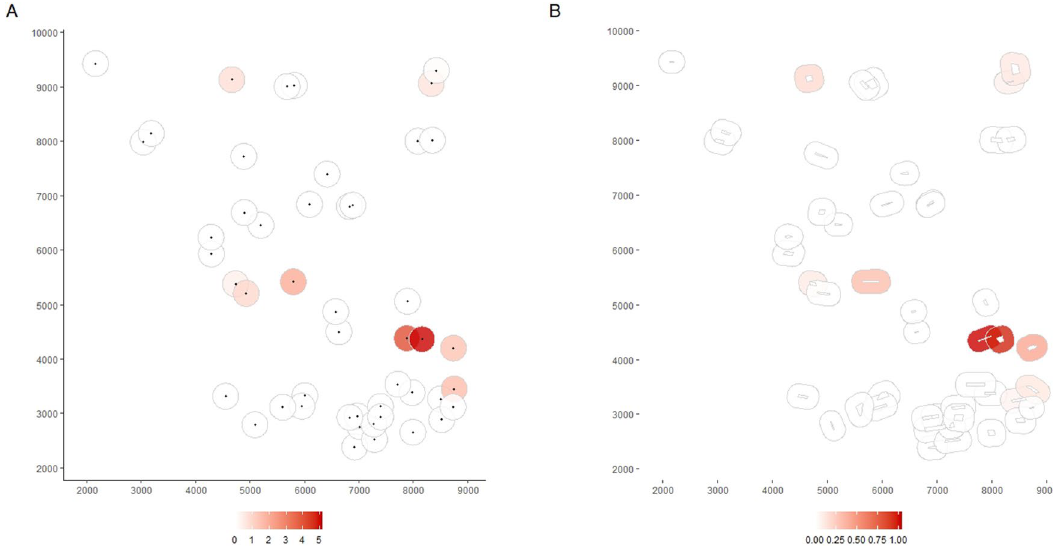
Figure 2. Maps of the predicted effect estimated by the Bsiland method obtained with the function plotBsiland.land(). The buffer model was estimated using the command: resB2 = Bsi lan d(C m oth ~ t rait + conv + or g ,la nd = l an d Cmo th, dat a = d ata Cmo th,border = border ) . Th e colored area represents th e b uffer around ea ch observation location estimated for the organic orchards effect. At the bottom margin, the bar color gives the effect intensity. Buffers are modeled in graphic A, from the observation locations (border = FALSE) and in graphic B from the border of the orchard of each observation (border = TRUE).